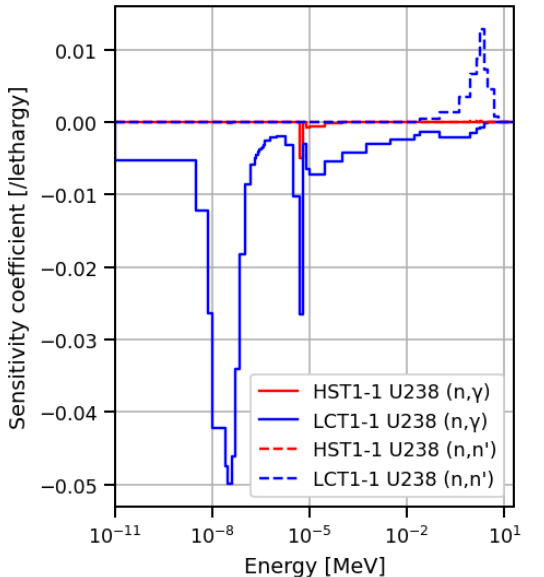
Figure 2. Sensitivity coefficients of U238 (n, γ ) and (n,n ’ )